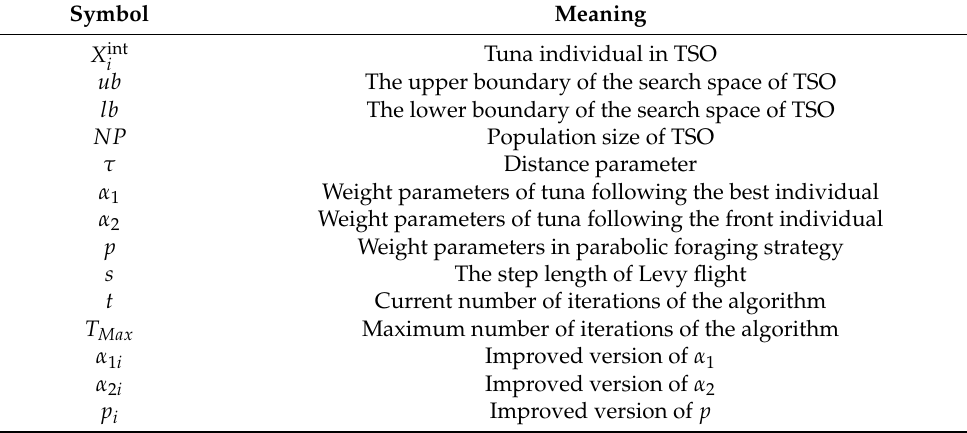
Table 1. Explanation of